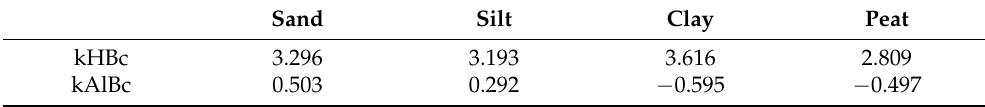
Table 2. Logarithmic GAPON exchange coefficient Al or H to Ca + Mg + K [eq m − 3 ] − 1/2 [18]. Sand Silt Clay Peat kHBc 3.296 3.193 3.616 2.809 kAlBc 0.503 0.292 − 0.595 −